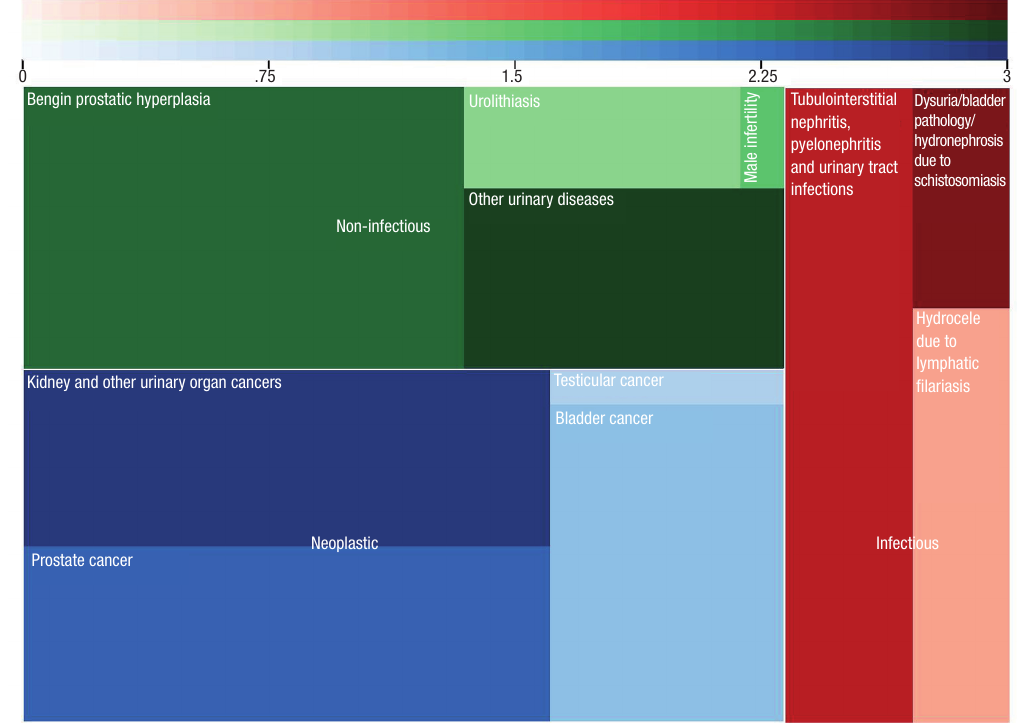
Figure 1 - Square pie chart representing percent of total DALY for ten men’s health and urologic diseases; area of each square/rectangle represents percentage of total burden.